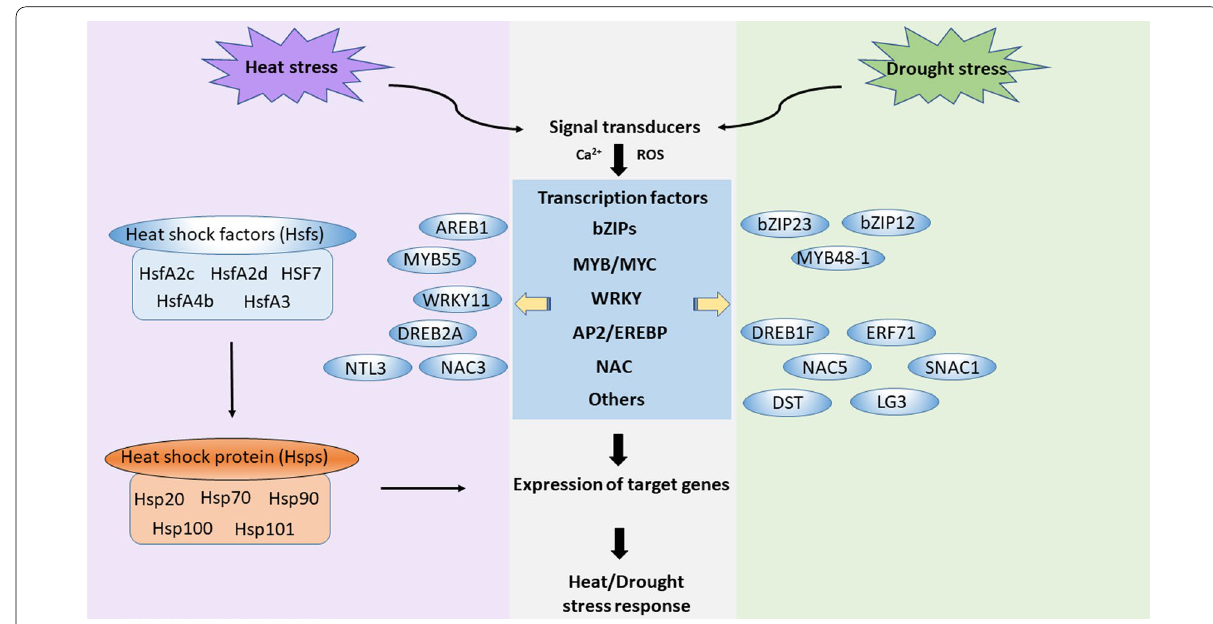
Fig. 1 A genetic network diagram of drought and heat stresses in